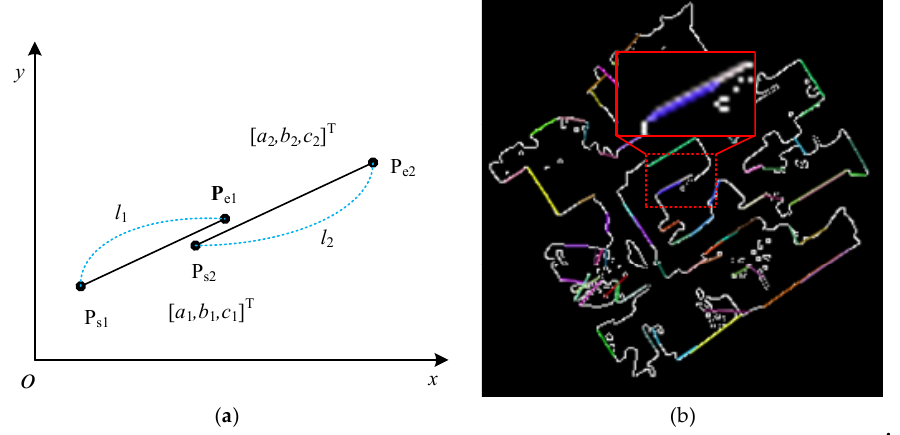
Figure 7. Line segments to be merged: ( a ) schematic diagram and ( b ) to be merged segments in the gird map. The points of line segment are P s and P e . The line parameters are [a, b, c] T . The line segment length is l.